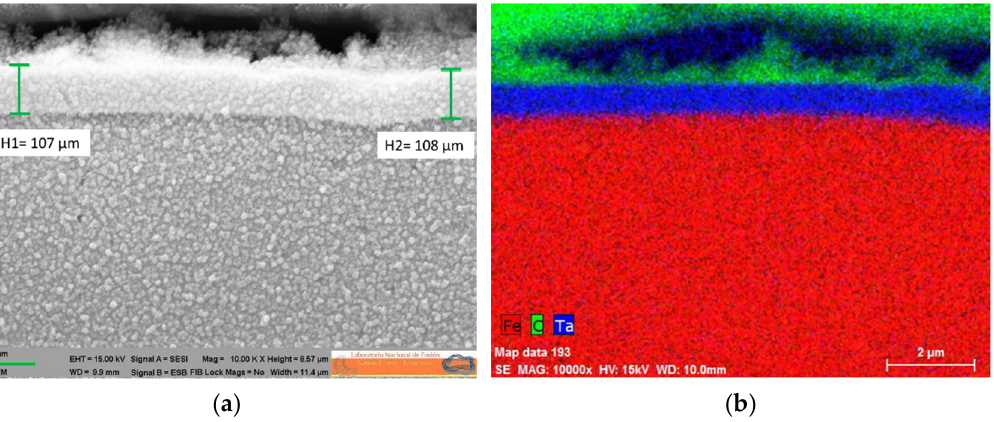
Figure 7. SEM microscopy image of a 316 stainless steel sample covered by tantalum, showing good adhesion with the substrate and uniform thickness ( a ). Mapping EDX analysis of the coated sample ( b ).